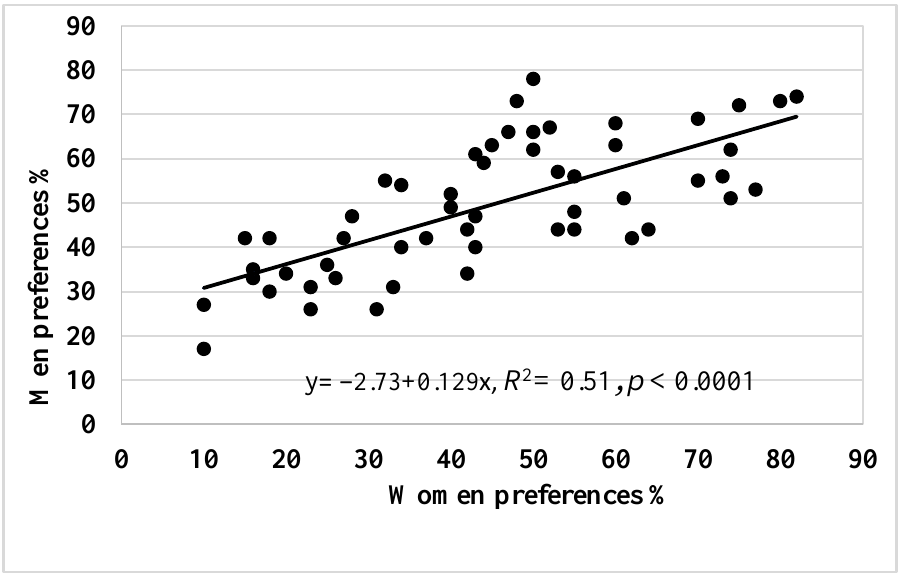
Figure 6. Women and men’s ranking of varieties in the 2013/2014 season in Yé limané.